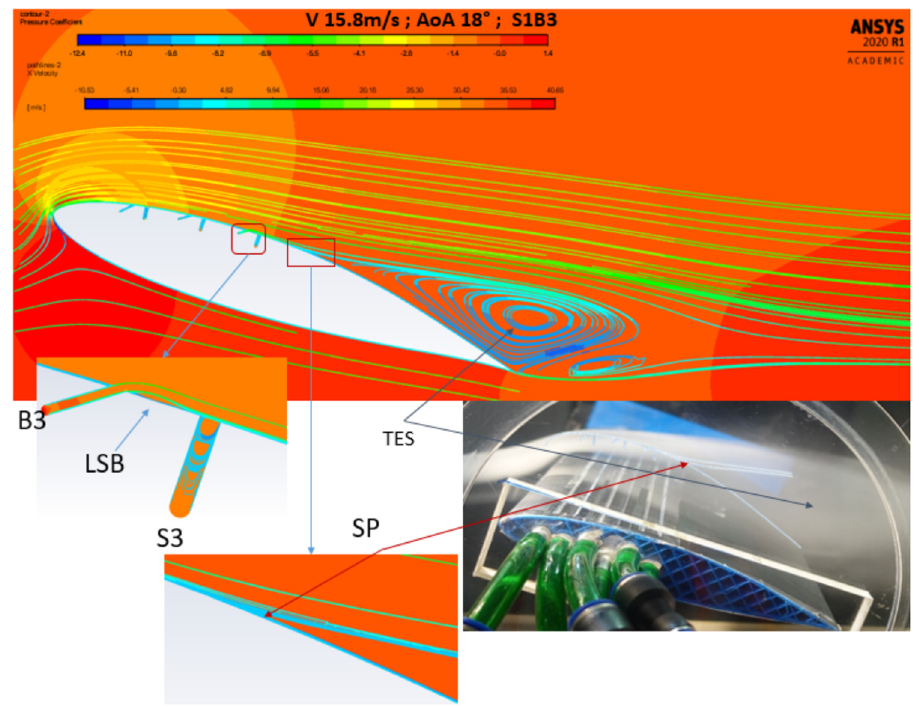
Fig. 7. Results of Flow visualisation around the aerofoil for the S1B3